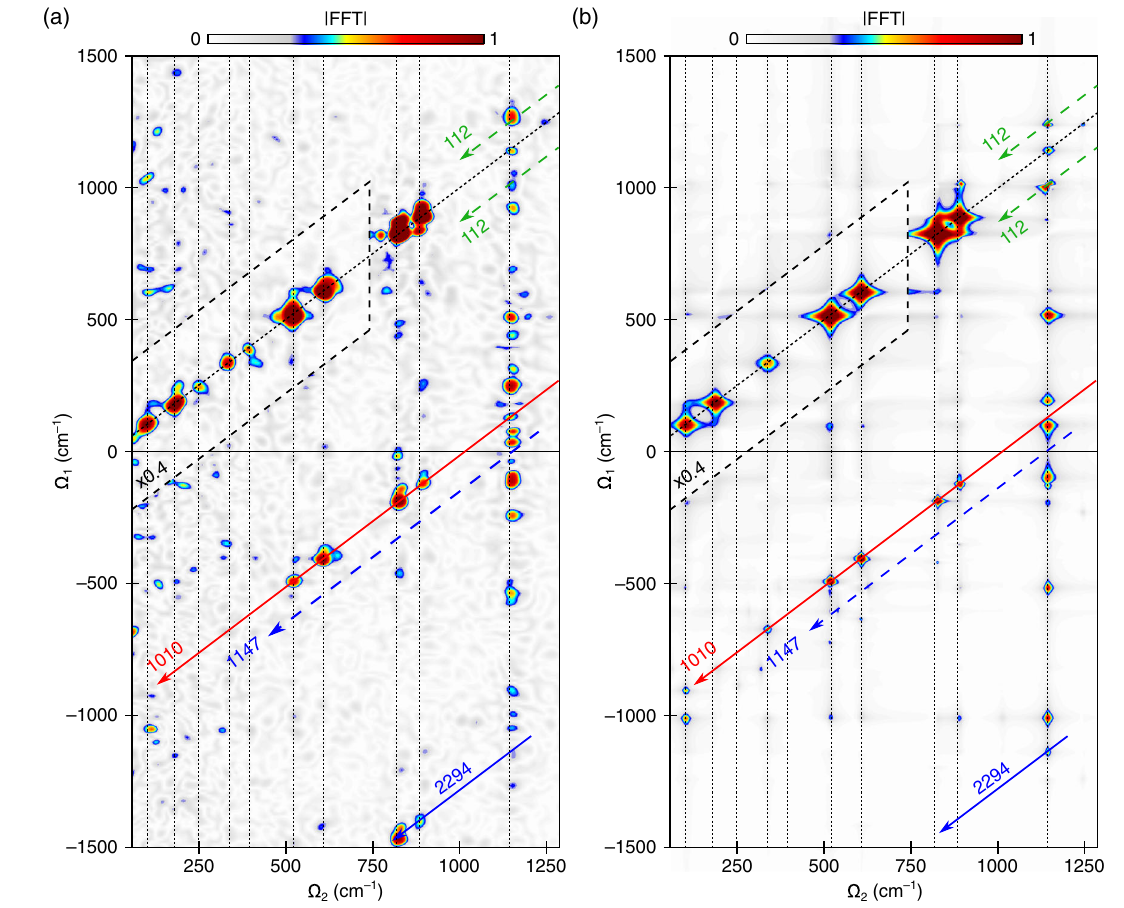
FIG. 3. The 2D-ISRS characterization of the first excited electronic state of GFP. (a) Experimental 2D-ISRS map and (b) fit to the linearly displaced harmonic model. Vertical dotted lines correspond to frequencies of the GFP excited-state vibrations, extracted by fitting the principal diagonal. The blue dashed and blue solid arrows highlight combination bands involving the fundamental and overtone frequencies of the 1147 -cm − 1 mode, respectively. As evidenced by the experimental map in panel (a), several couplings with the overtone are present, while there are no peaks on the blue dashed arrow. The red arrow highlights combination bands involving the mode at 1010 cm − 1 that is absent along the principal diagonal. The green dashed arrow highlights a combination band between the 1147- and 112 -cm − 1 modes. The dashed area around the principal diagonal has been scaled by 0.4 for visual